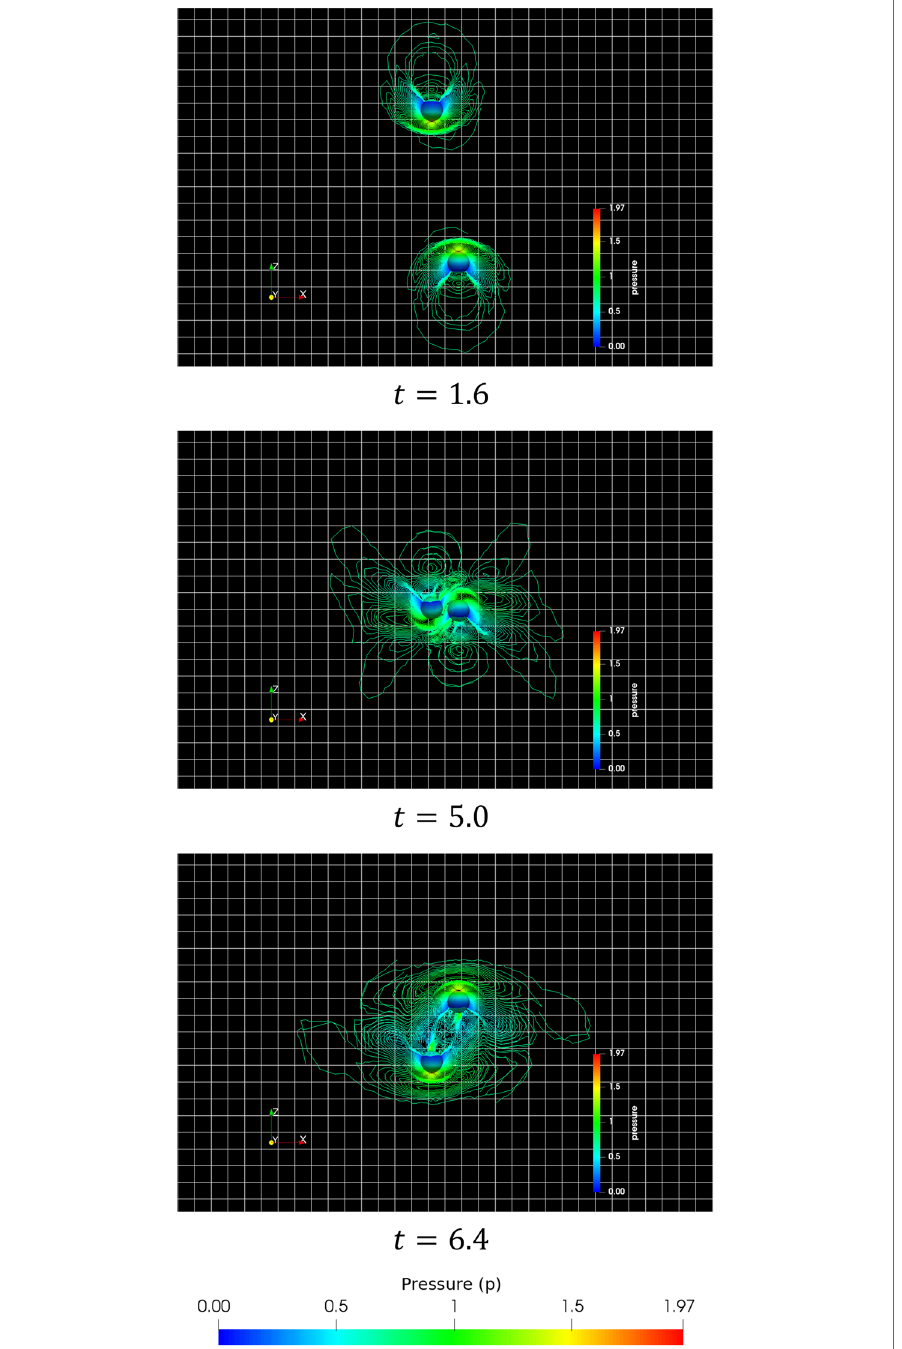
Fig. 13 Pressure distribution on the sphere surface and pressure contour at each time step (crossing